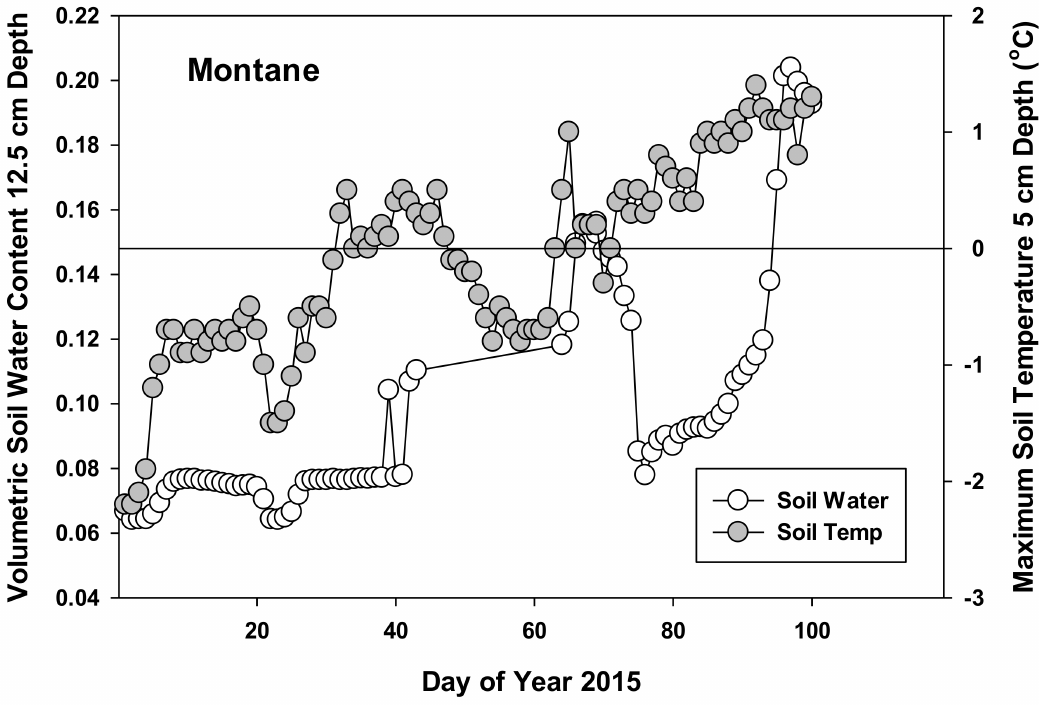
Figure 7. Maximum soil temperature at 5 cm ( ◦ C) and volumetric soil water content at 12.5 cm during 2015 at the Montane West